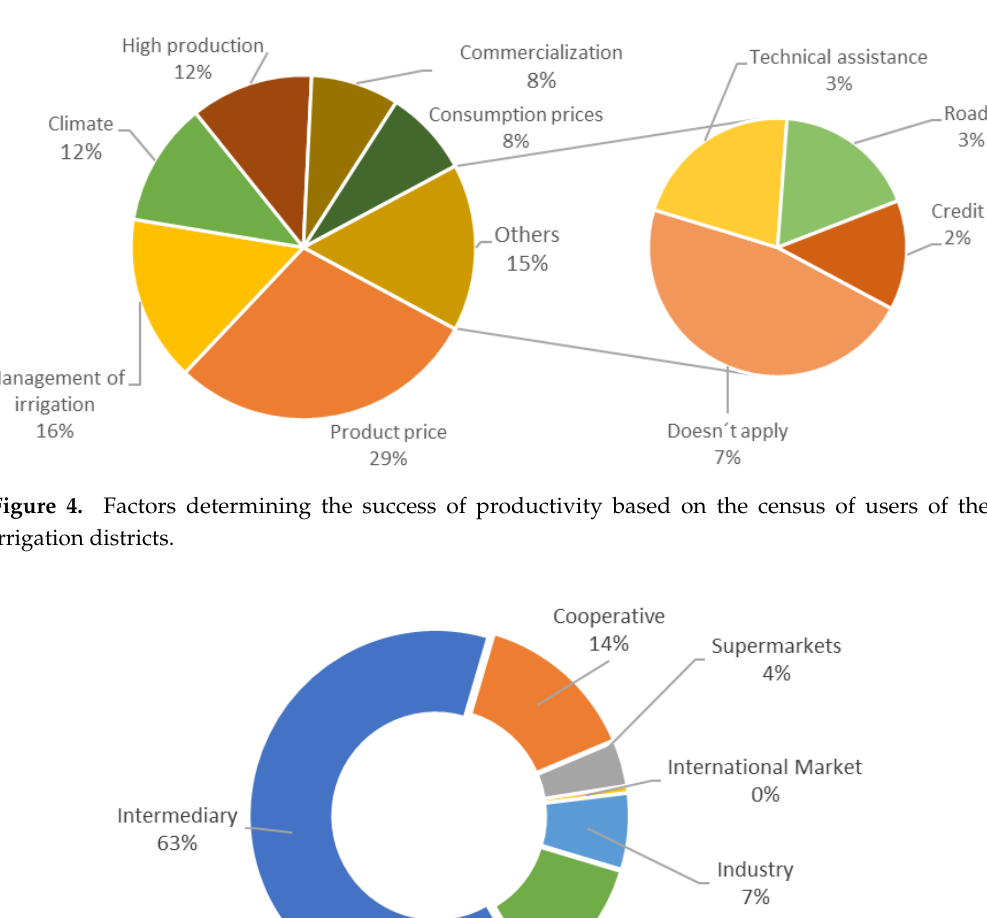
Figure 5. Destination of production.